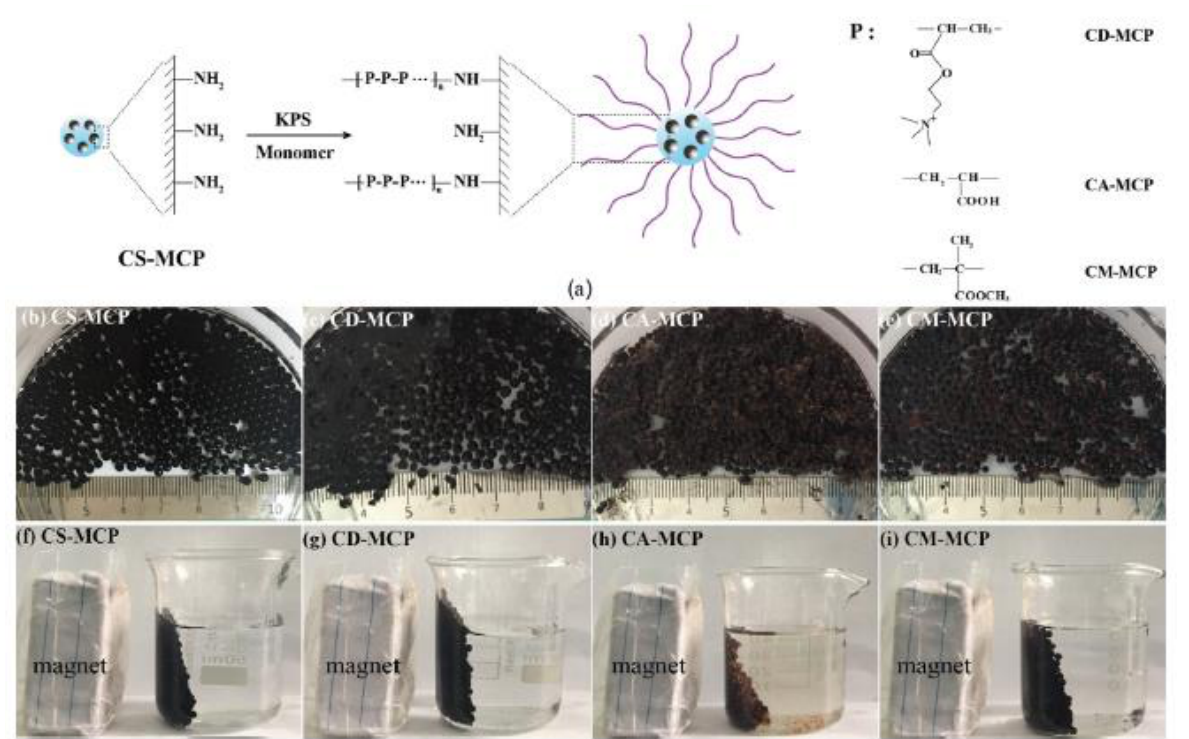
Figure 3. ( a ) Synthetic route, ( b – e ) photos, and ( f – i ) magnetic separation property of different adsorbents in water at room temperature [20].